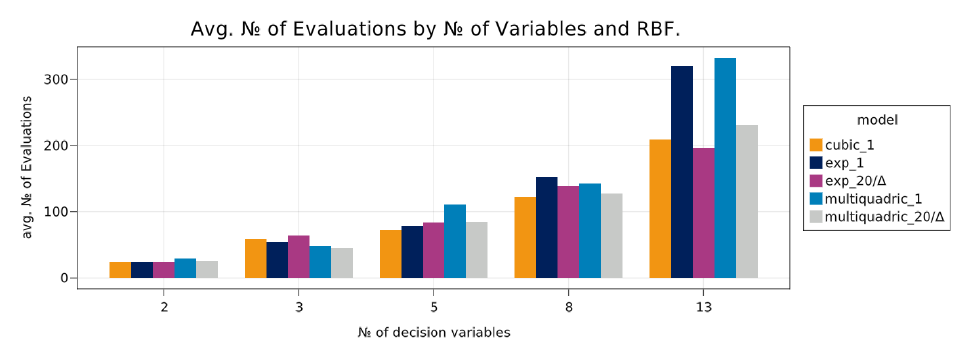
Figure 7. Each group of bars shows the influence of a adaptive shape radius on the performance of different RBF models (tested on ZDT3) for different decision space dimensions. From left to right the bars correspond to the cubic RBF, the Gaussian—with constant shape factor 1 and with adaptive shape factor 20/ ∆ ( t ) —and the Multiquadric—with shape factors 1 and 20/ ∆ ( t )